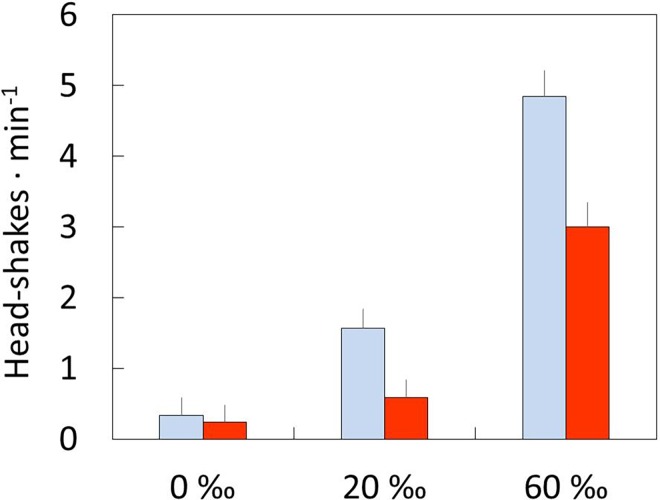
Behaviour response.Head-shaking behaviour (mean ± SE) of captive-reared stilt chicks before (grey bars) and after (white bars) ingesting diptera larvae at 0, 20, and 60 ‰ salinity. There were significant differences among treatments (see text for further details).